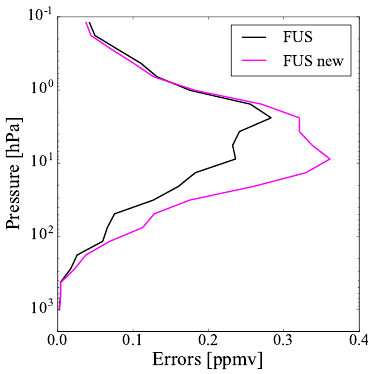
Figure 9. Errors of the fused profile when we use the original (black line) and the generalized (magenta line) CDF for case 3.